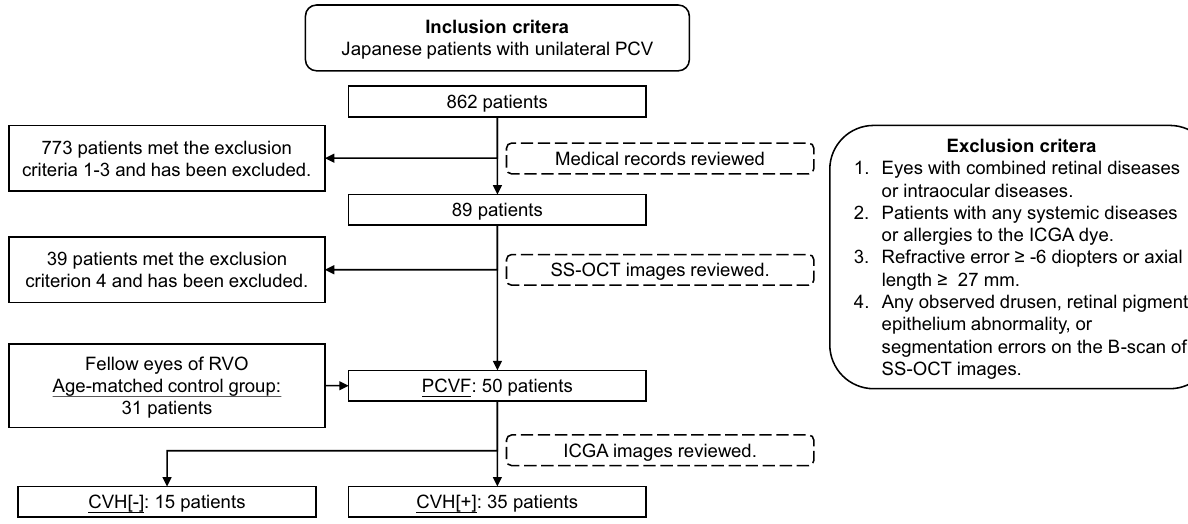
Figure 1. Flow chart of the patient extraction and grouping process. First, we included the medical records of all patients who had been diagnosed as having PCV in our hospital between June 2017 and August 2020. We checked the medical records for exclusion criterion 1–3. Then we checked the relevant images of each patient on the SS-OCT machine, finally including 50 PCV patients as the PCVF group. We selected the control group using the same steps. Finally, we checked the ICGA images of the PCVF group members and divided them into the CVH[+] and CVH[−] groups. FV choriocapillaris flow void, PCVF PCV fellow eyes. Control